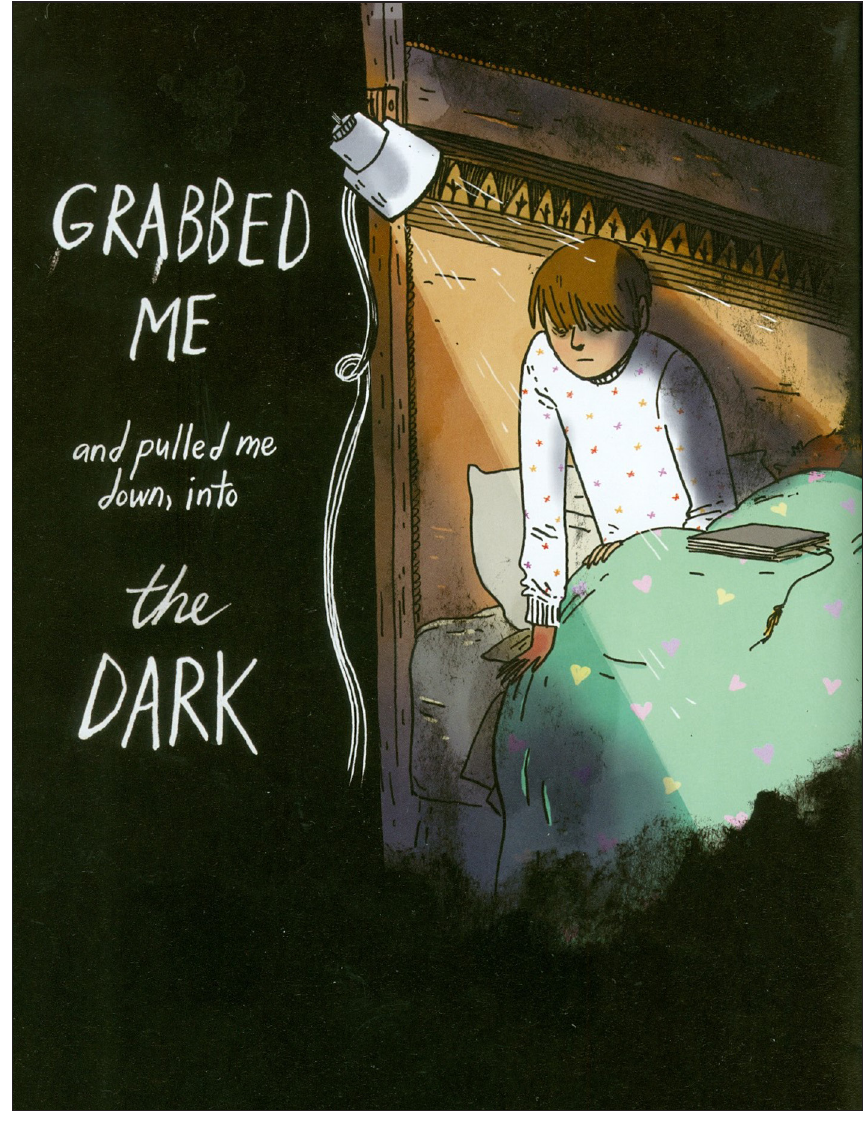
Figure 1: Carroll, E (2014). Through the Woods (New York: Faber & Faber, n.pag.) © Emily